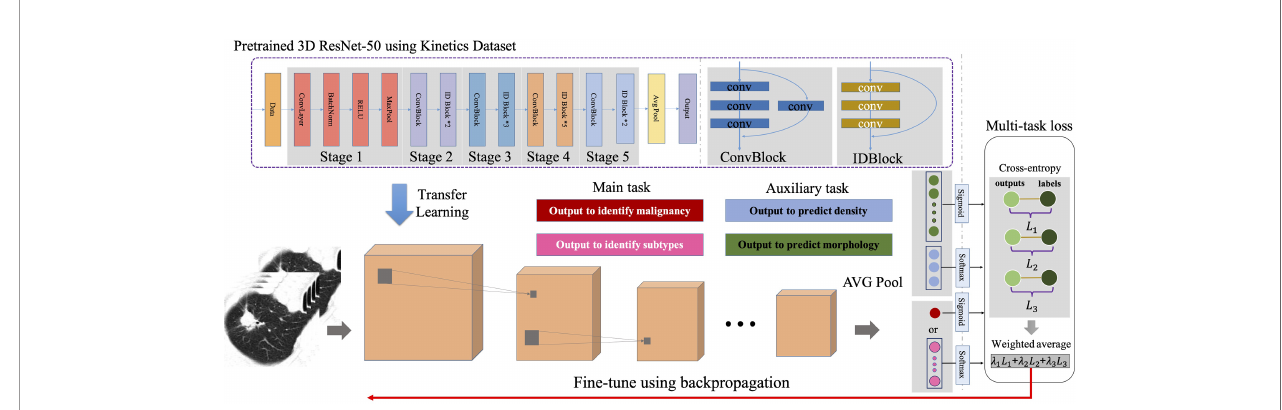
FIGURE 1 | Architecture of our deep learning